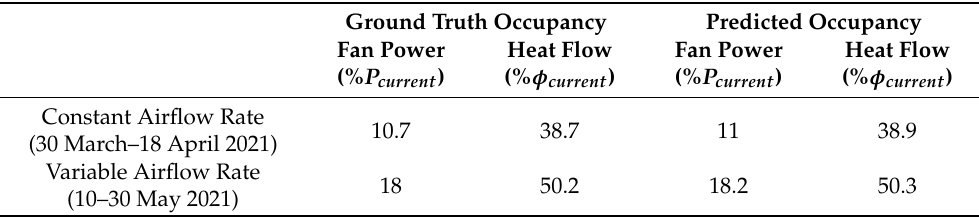
Table 7. Simplified energy analysis for ideal control scenario based on the measured and predicted oc- cupancy detection, presented for the two periods, one with constant and another with variable airflow. Ground Truth Occupancy Predicted